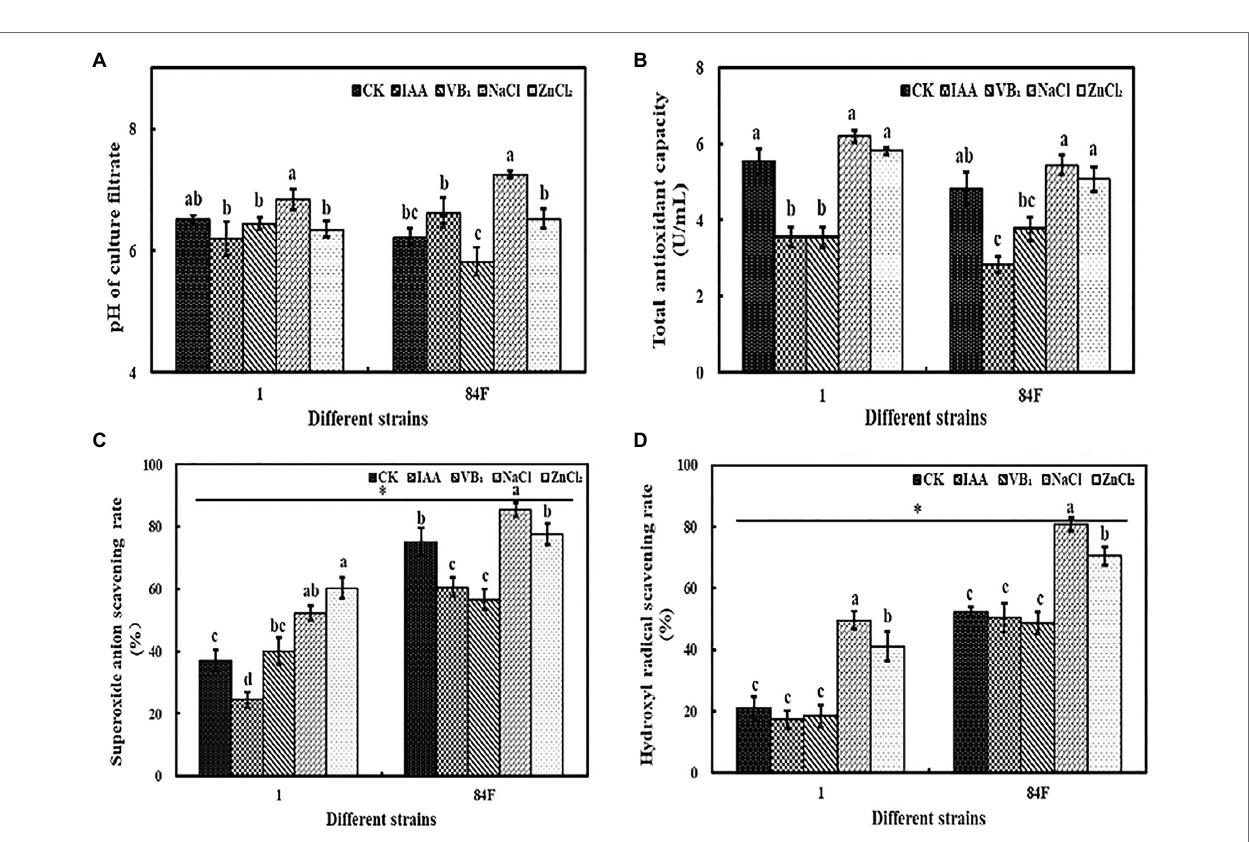
FIGURE 2 | PH and antioxidant ability of E. sinensis under different treatments for 4 weeks. (A) is PH, (B) is total antioxidant capacity of culture filtrate, (C) is superoxide anion radicals scavenging ability, and (D) is hydroxyl radical scavenging ability. The same as Figure 1